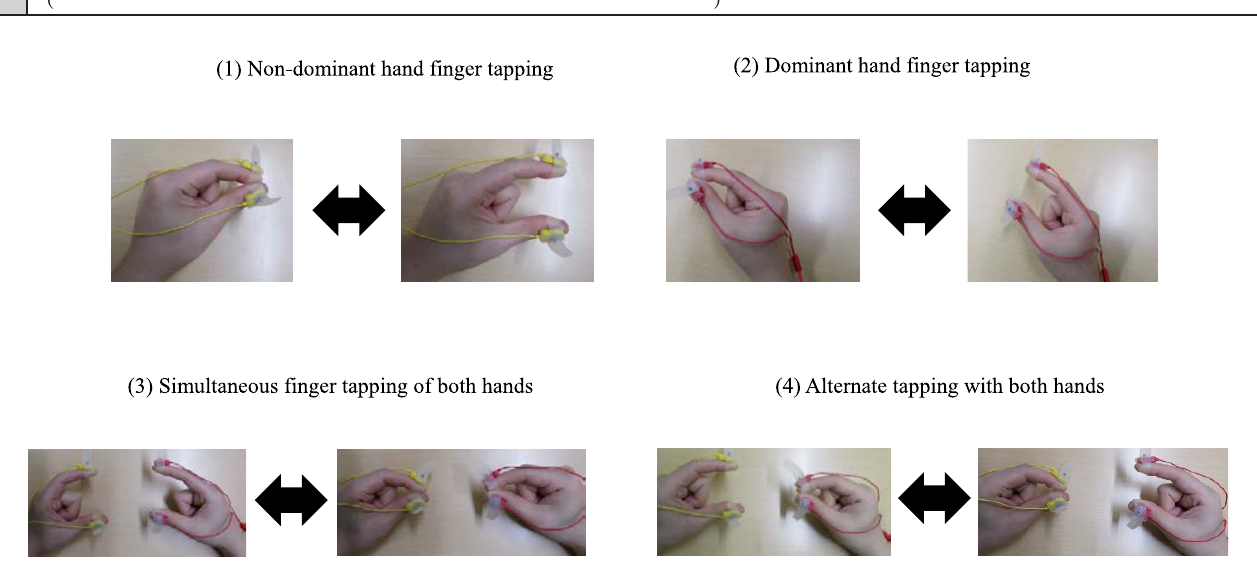
Figure 2 Finger-tapping movement (1) Non-dominant hand finger tapping: Perform finger tapping with the left thumb and index finger as fast as possible. (2) Dominant hand finger tapping: Perform finger tapping with the right thumb and index finger as fast as possible. (3) Simultaneous finger tapping of both hands: Perform finger tapping of both hands as fast as possible at the same time. (4) Alternate tapping with both hands: Perform finger tapping alternately with the left and right hands, as fast as possible. Perform (1) to (4) described above for 15 s, keeping the distance between the thumb and index finger 3 to